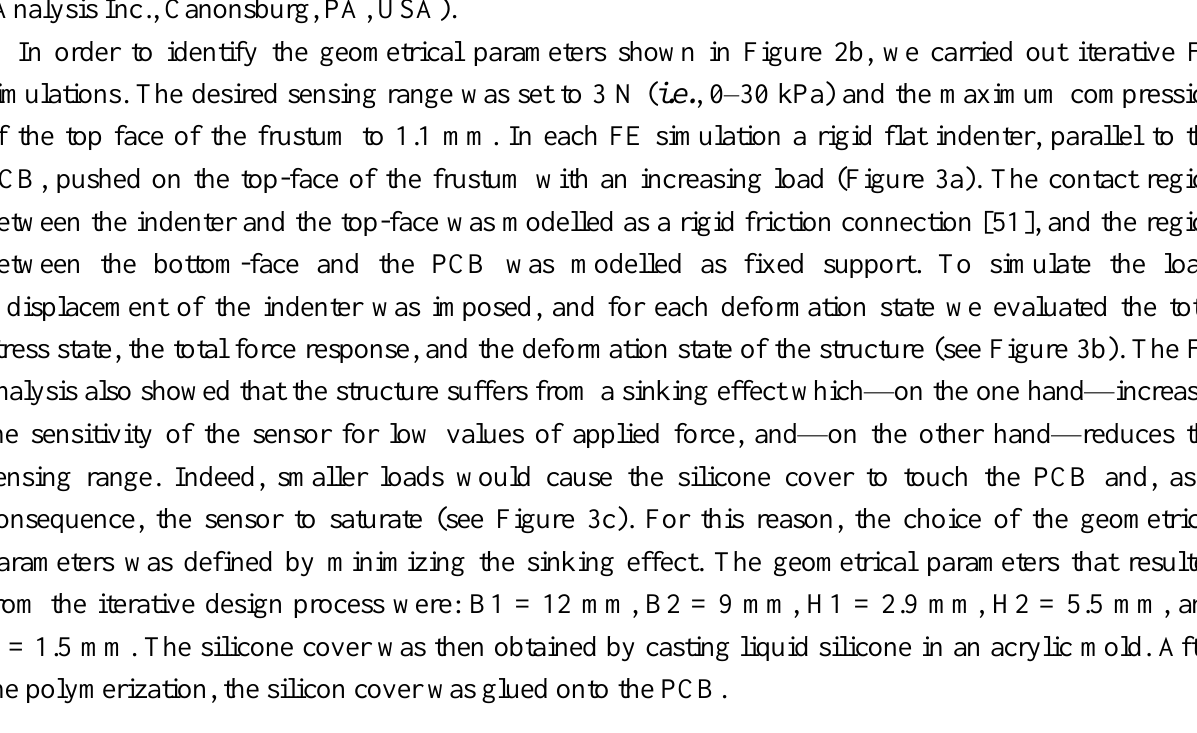
Figure 3. 3-Dimensional finite-element model: ( a ) model of the sensitive element; ( b ) total deformation of the silicone structure; ( c ) detail of the sinking